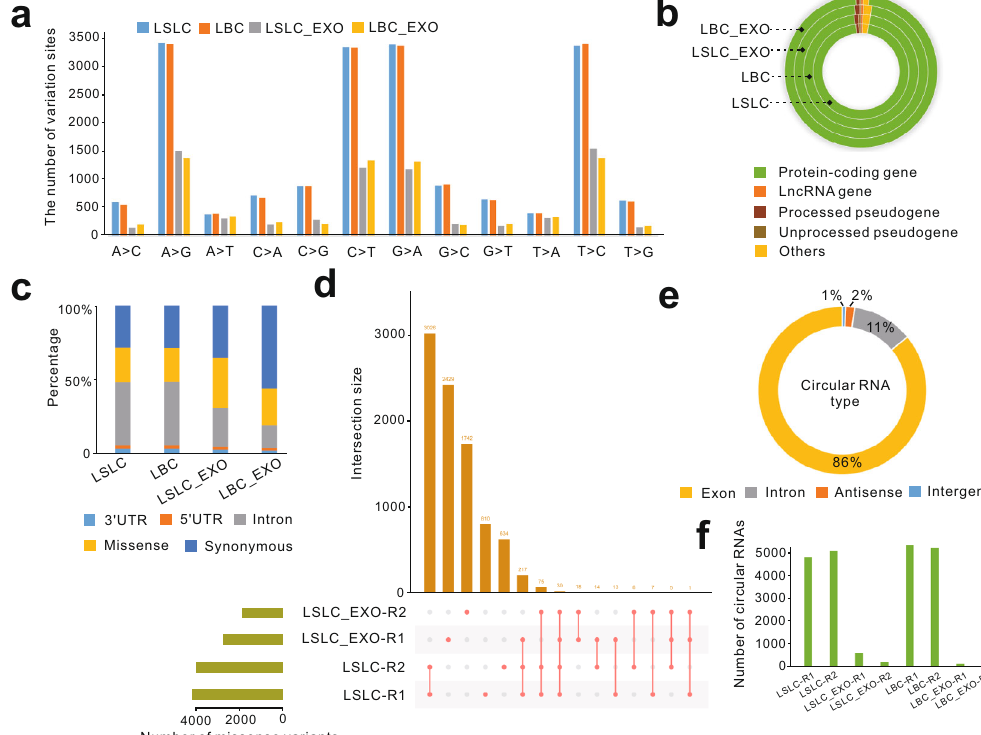
Fig. 4 The statistics of RNA variants and circular RNAs. a Distribution of variant types identi fi ed from cellular and exosomal transcriptomes. b Distribution of RNA variants in different gene types. c Distribution of RNA variants in different regions of protein-coding genes. d Matrix layout for all intersections of LSLC and LSLC-EXO samples, sorted by intersection size. Pink dots in the matrix indicate sets that are part of the intersection. e The proportion of circRNAs from different genomic regions. f The number of circRNAs identi fi ed from LSLC and LSLC-EXO